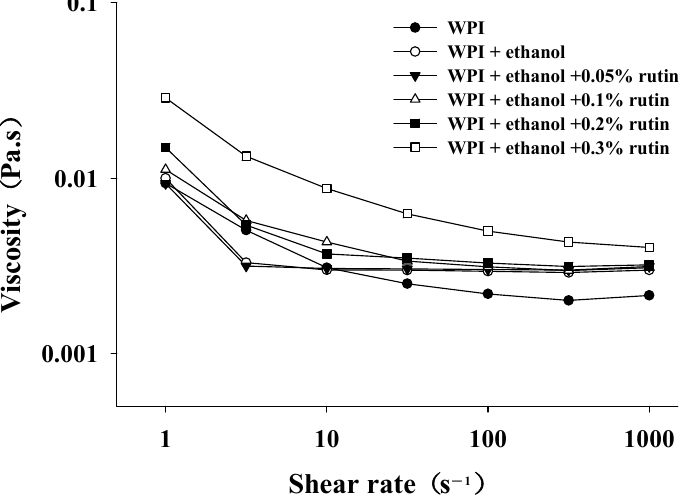
Figure 4. The effects of ethanol (15%, v / v ) and different levels of rutin (0.05%, 0.1%, 0.2% and 0.3% w / v ) on the viscosity of WPI.